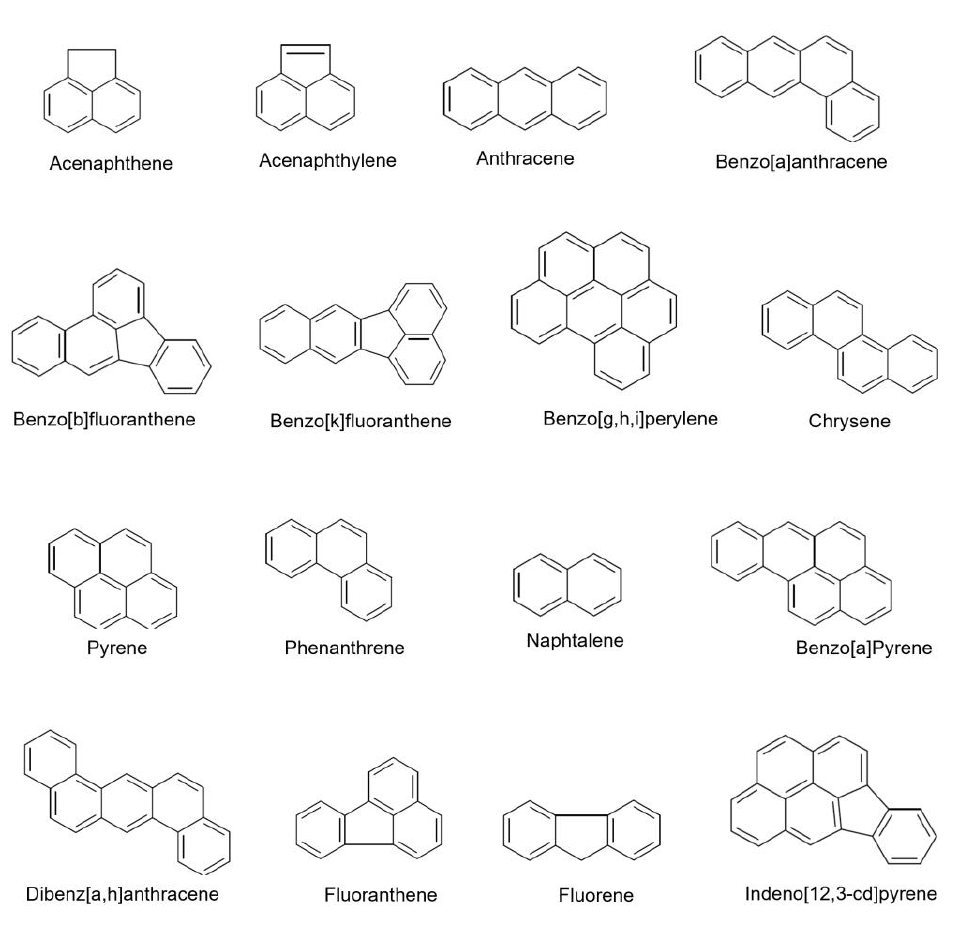
Figure 1. Chemical structures of the analyzed PAHs.